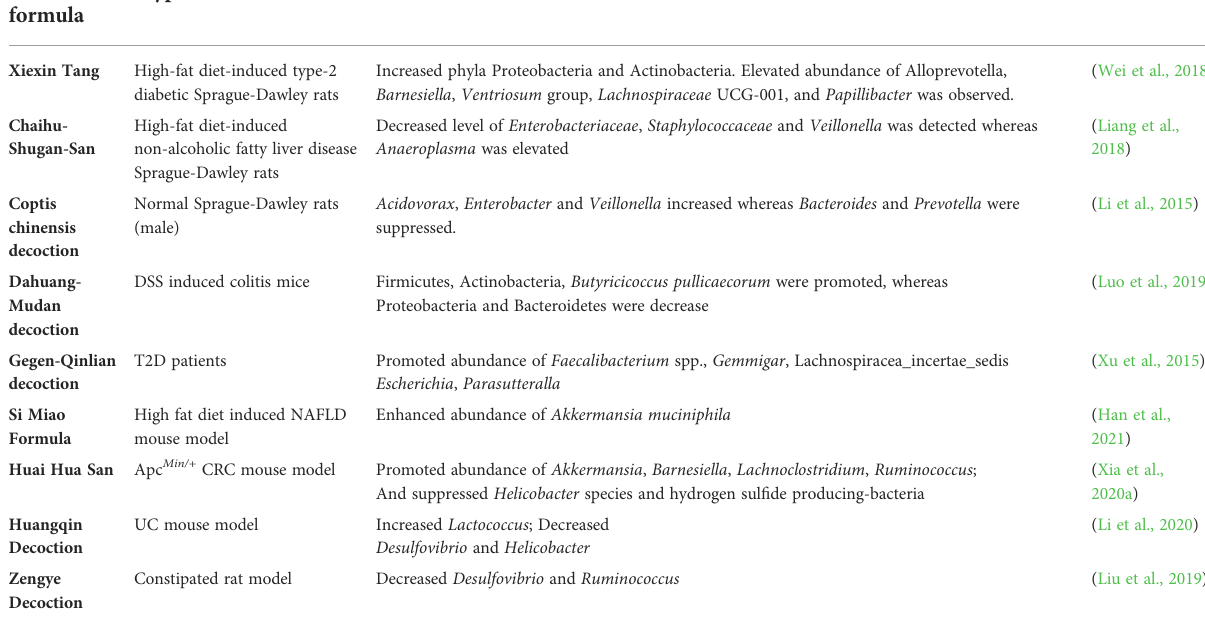
TABLE 1 Herbal formula effects the GM. Herbal